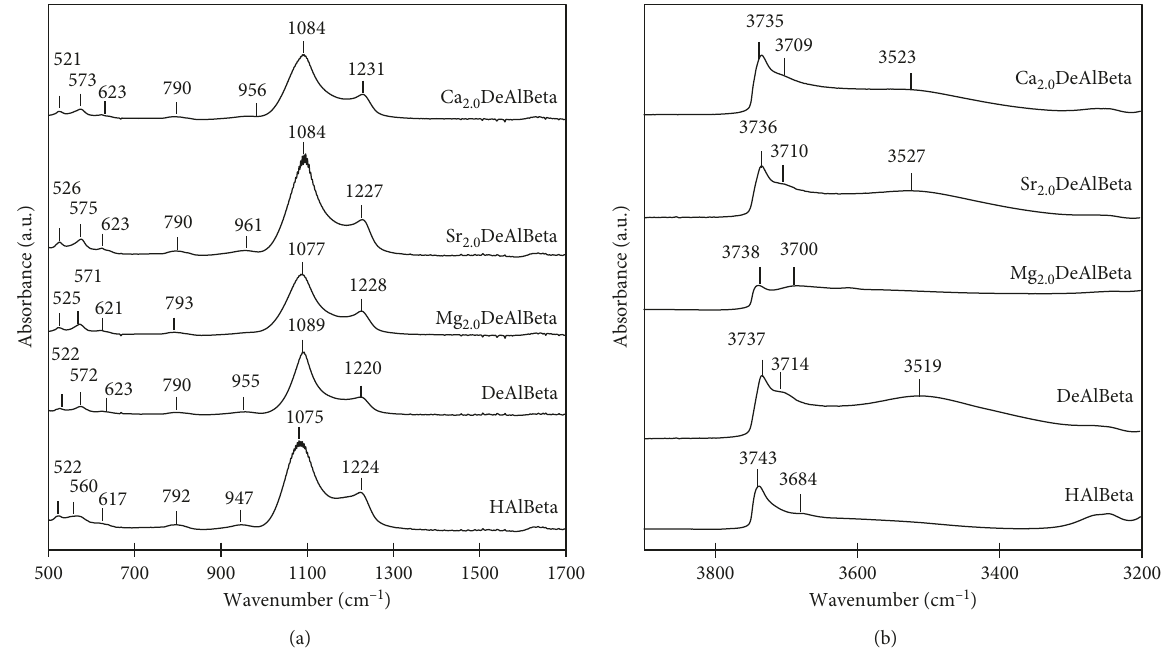
Figure 4: FTIR spectra of HAlBeta, DeAlBeta, Mg 2.0 DeAlBeta, Sr 2.0 DeAlBeta, and Ca 2.0 DeAlBeta samples in the (a) framework vibration region and (b) vibrational range of OH groups.